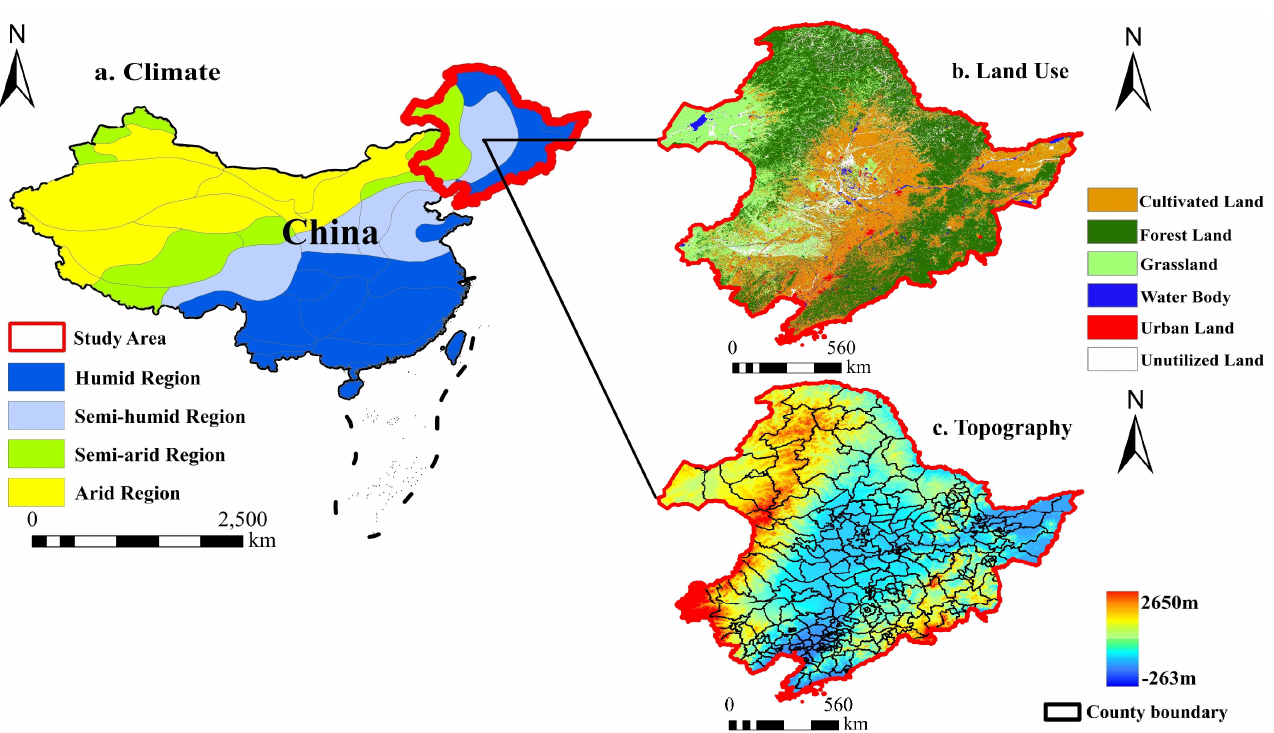
Figure 1. Location and climate zones map ( a ), land-use map ( b ) and topography ( c ) of study area. Land-use map, including six categories, was monitored in